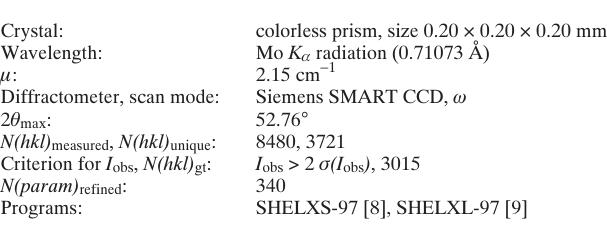
Table 1. Data collection and handling.